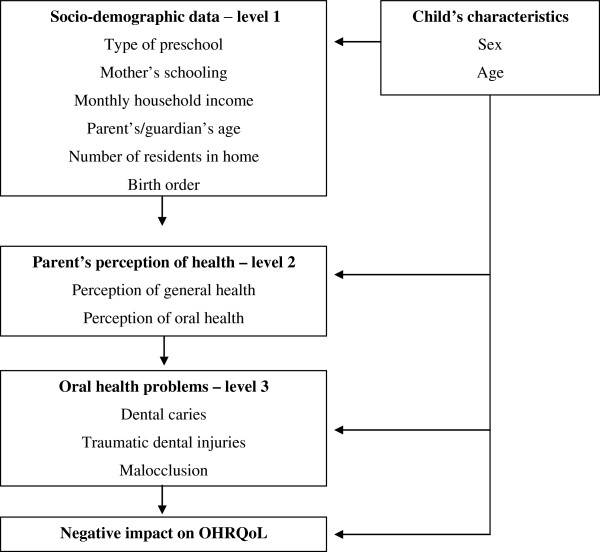
Analysis model used in the study.